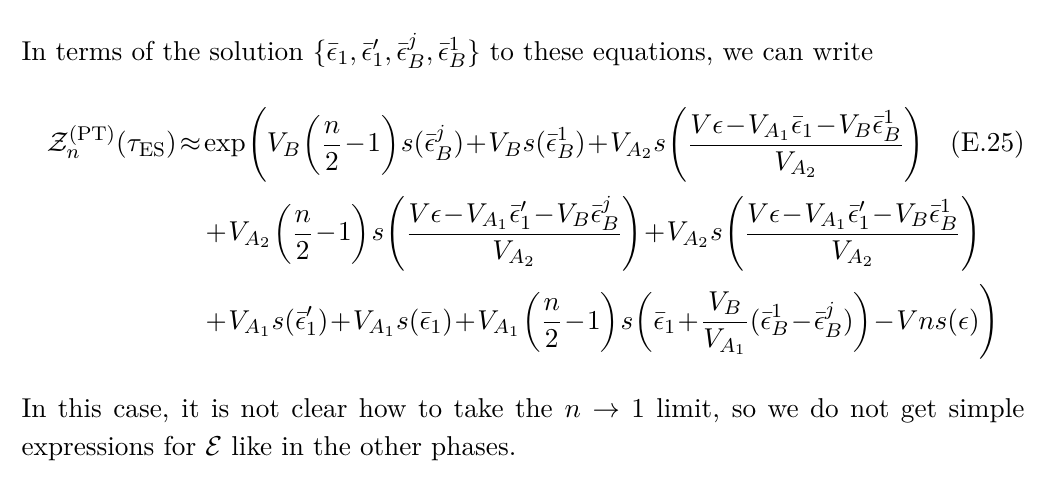
Figure 32 . Phase transition lines for the n = 4 , 6 Renyi negativities in the homogeneous micro- canonical ensemble case, with s ( (cid:15) ) given by